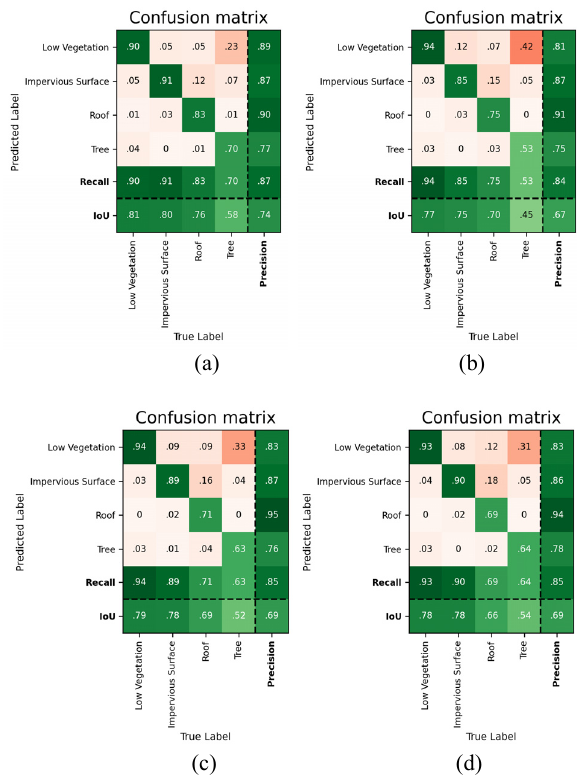
Figure 4 . Confusion matrices on (a) the proposed network (b) FCN, (c) Single-ST, and (d) PLF-ST.